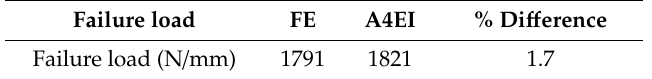
Figure A4. Finite element model of the joint. Table A1. Predicted failure loads (N / mm) from the finite element (FE) and analytical (AE4I)